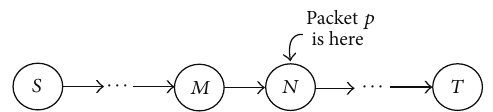
Figure 1: Packet 𝑝 travelling from source node ( 𝑆 ) to sink node ( 𝑇